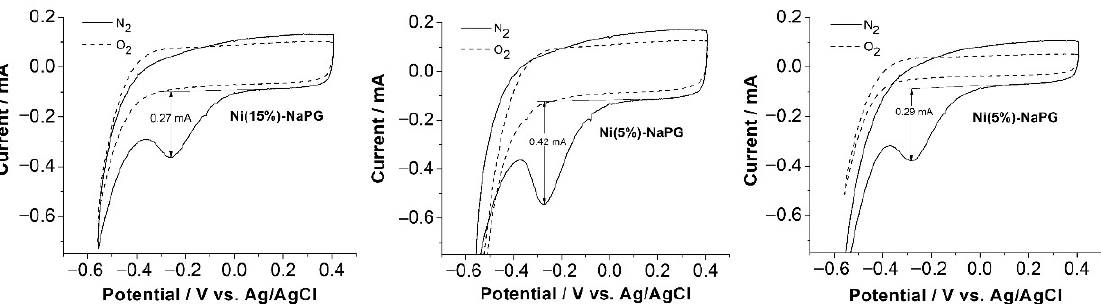
Figure 3. CV indicating amplitudes of cathodic peaks for the ORR on GC electrodes of Ni (15%)-NaPG ( left ), Ni(20%)-NaPG ( center ), and Ni(25%)-NaPG ( right ) coordination biopolymers in a nitrogen-protected environment (dashed curves) or oxygenated 0.5 M H 2 SO 4 (solid curves) at a scan rate of 50 mV s − 1 ; GC electrode area: 0.0707 cm 2 . According to the CV curves of the studied coordination biopolymers, all of them ex- samples. In solutions saturated with argon, there are no reduction peaks.